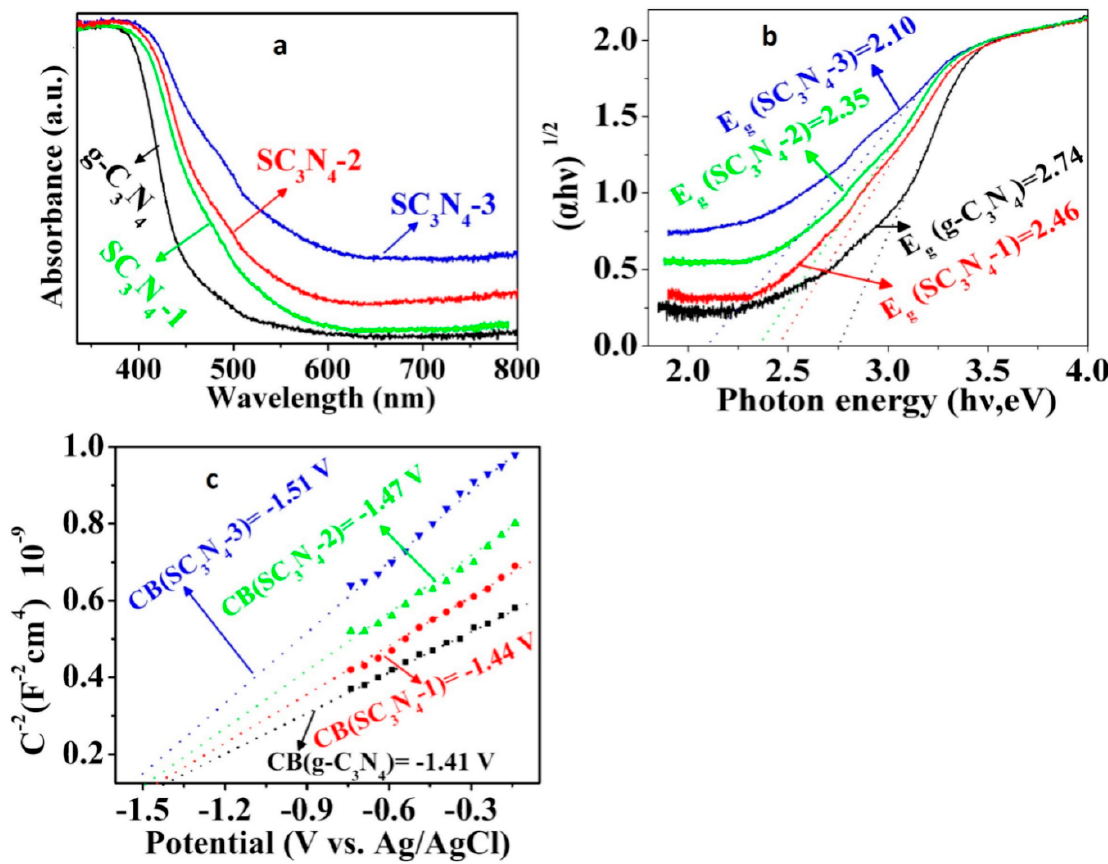
Figure 6. Optical absorption spectra of g-C 3 N 4 and S-g-C 3 N 4 (SC 3 N 4 ) samples ( a ); plots of ( α h υ ) 1 / 2 vs. photon energy (h υ ) ( b ) and electrochemical Mott–Schottky plots of g-C 3 N 4 and S-g-C 3 N 4 samples ( c ). Reprinted from [101] Copyright (2017), with permission from Elsevier.